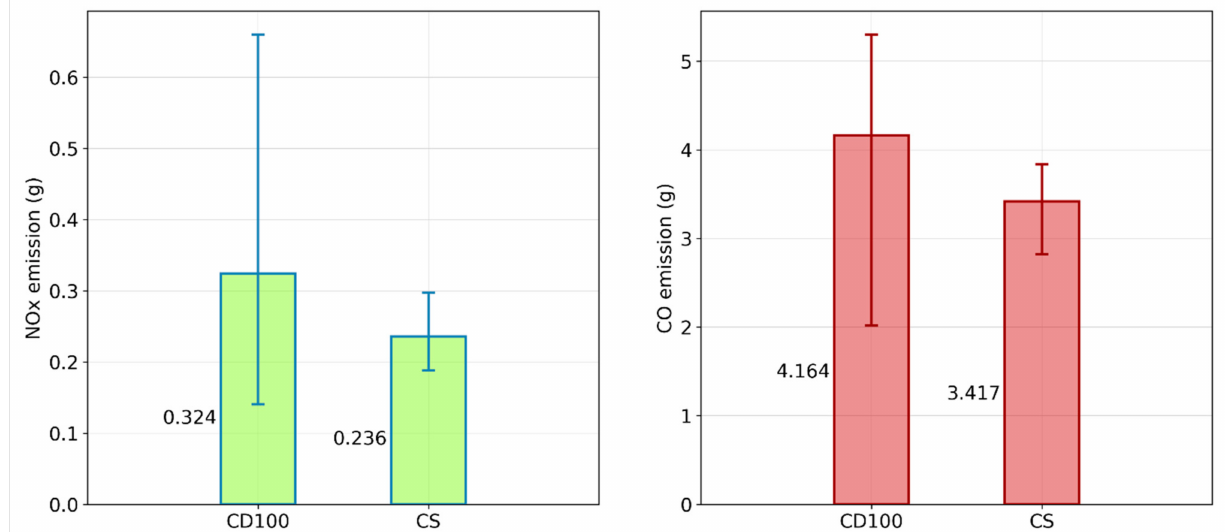
Figure 7. CO and NOx emissions on RDE compliant tests during the first cumulative 300 s of internal combustion engine operation, not necessarily consecutive. CD100 indicates charge-depleting operation with initial battery state of charge (SOC) equal to 100%; CS indicated charge-sustaining operation, i.e., starting with the minimum SOC. All tests were performed in the default user-selectable mode of operation. Error bars on the graph represent maximum and minimum values. See the Methods section for additional